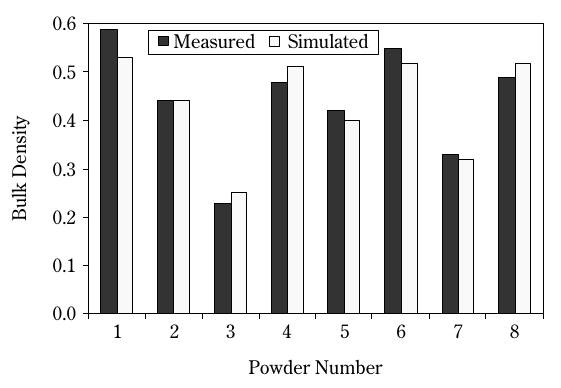
0.300.350.400.450.500.550.60 Fig. 8 Comparison of bulk packing densities obtained using DigiPac and LPM for PWD9 with nine different size distri-